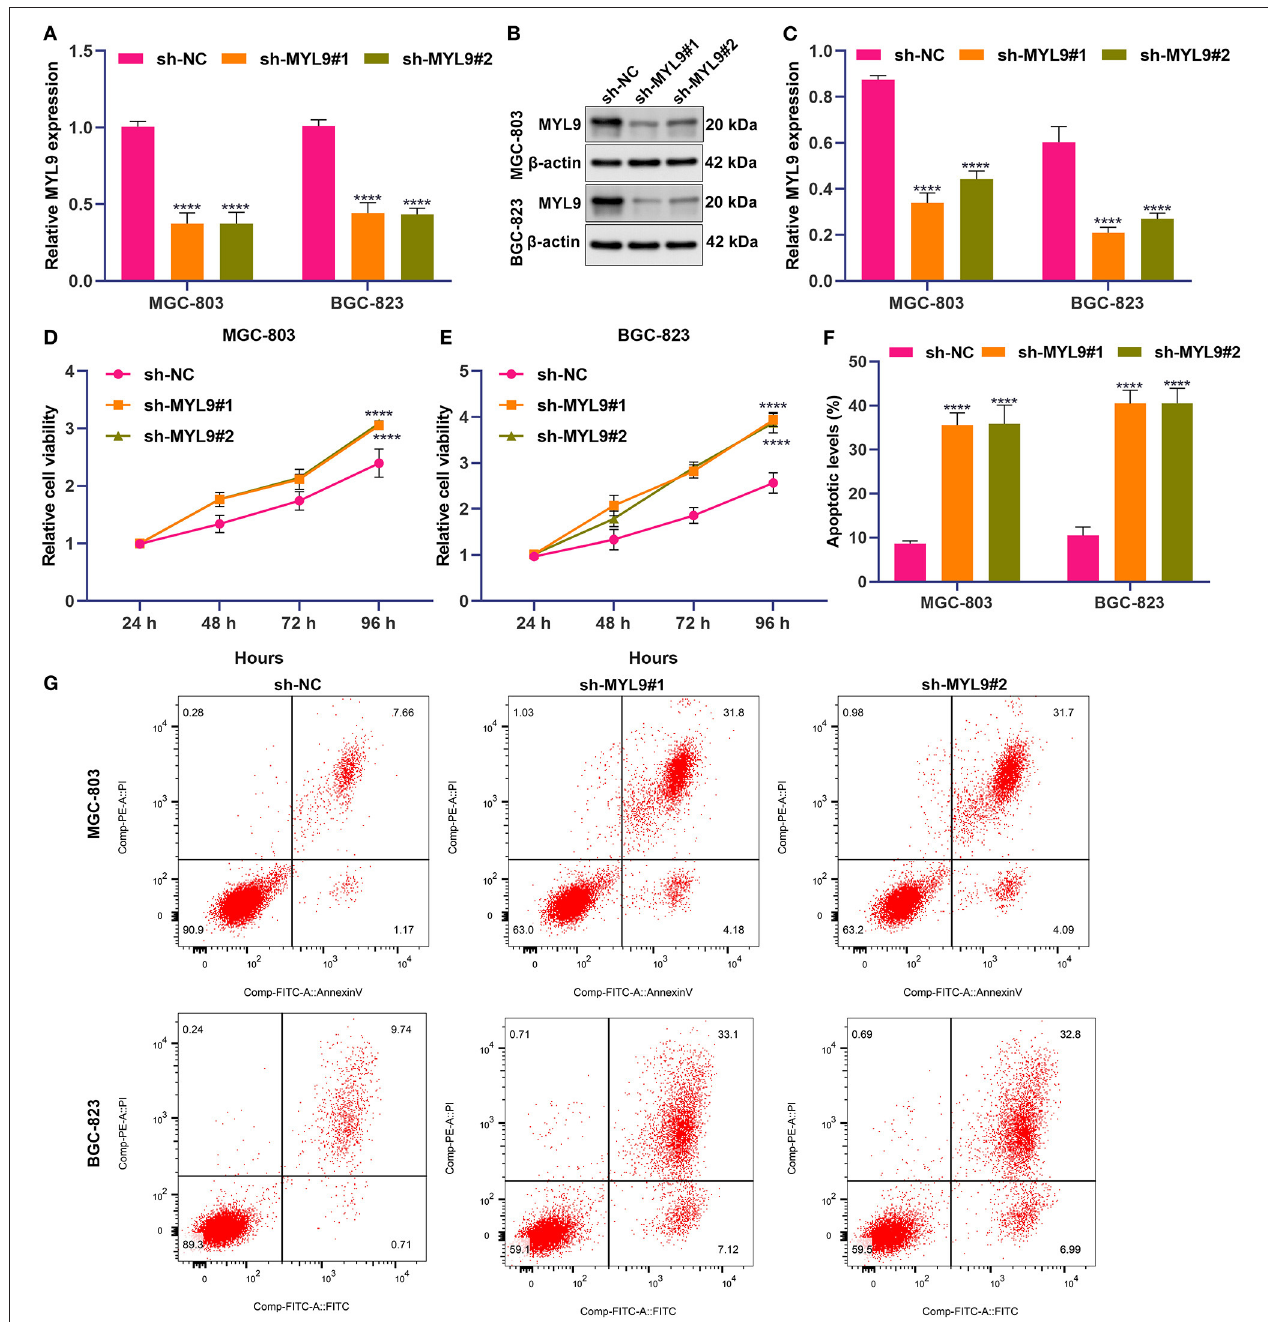
FIGURE 8 | MYL9 loss weakens proliferation and triggers apoptosis in gastric cancer cells. (A–C) MYL9 expressions were determined in MGC-803 and BGC-823 cells under shRNAs targeting MYL9 transfections with RT-qPCR and Western blotting. (D,E) Viable MGC-803 and BGC-823 cells were evaluated following shRNAs against MYL9 transfections through CCK-8. (F,G) Apoptotic MGC-803 and BGC-823 cells were investigated after shRNAs against MYL9 transfections with flow cytometry. **** p < 0.0001.